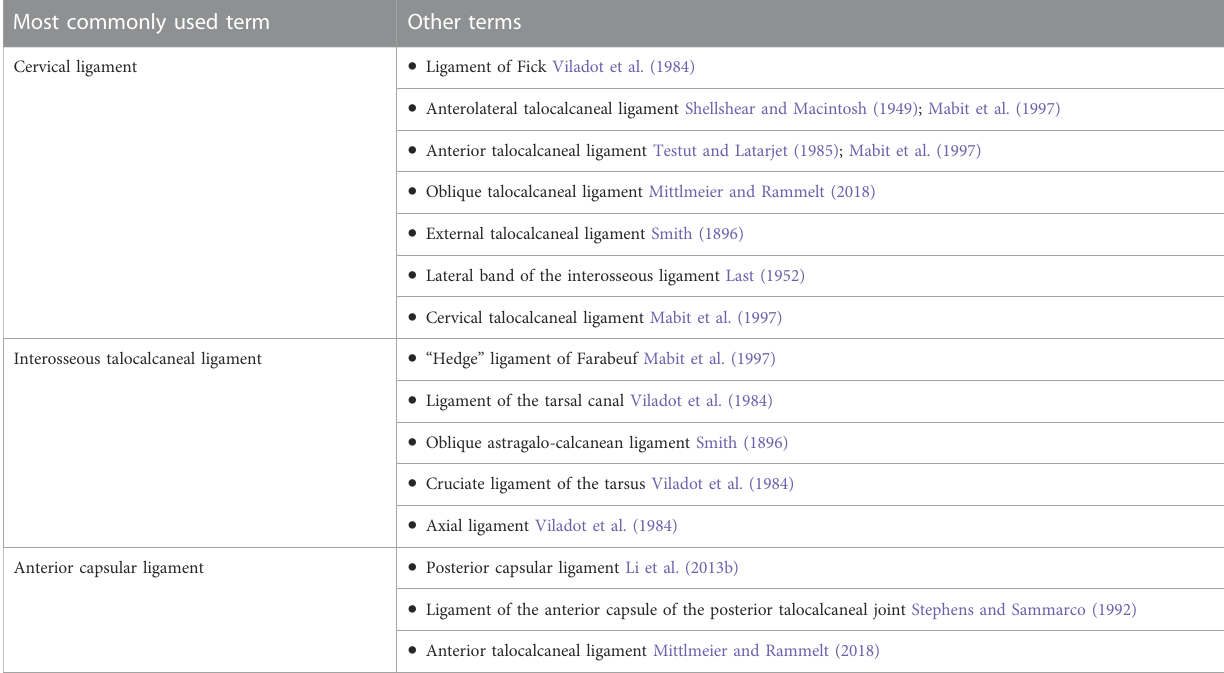
Anterior capsular